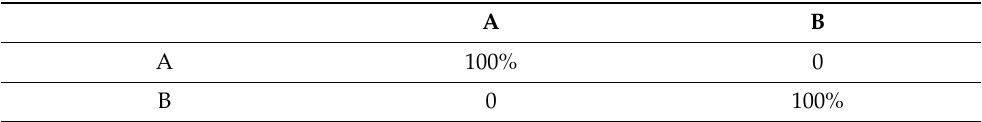
Table 8. Confusion matrix achieved for the Navel variety accessions of set 1: A, Baianinha Piracicaba, B, Bahia Vale del Cauca.